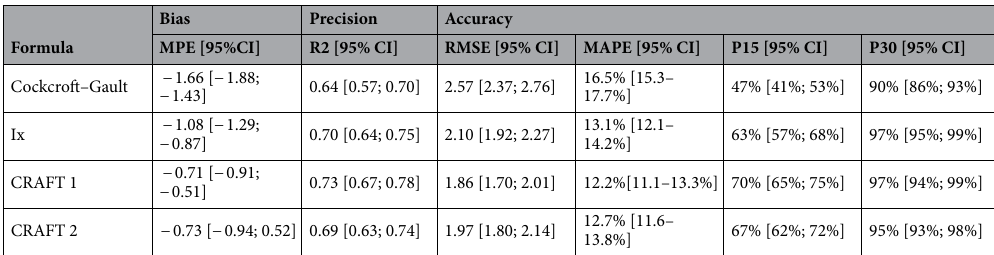
Table 3. Equation performance in kidney donor dataset (n = 287). Confidence intervals were calculated with the combined variance of multiple imputation (10×) and bootstrap (1000×). MPE mean prediction error (mmol/day), MAPE mean absolute percentage error, RMSE root mean squared error (mmol/day), R2 the R2-value calculated with linear regression, p15/p30 the percentage of points that fall within 15%/30% of the outcome.